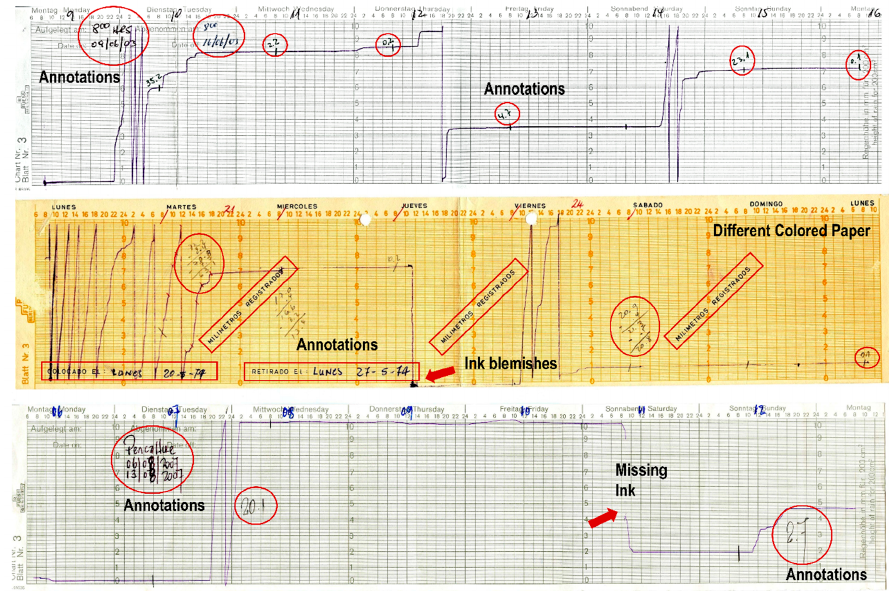
Figure 8. Common defects and blemishes on pluviograph bands include different colored paper strips, annotations on band trace, missing trace, and excessive ink blemishes, among many others.